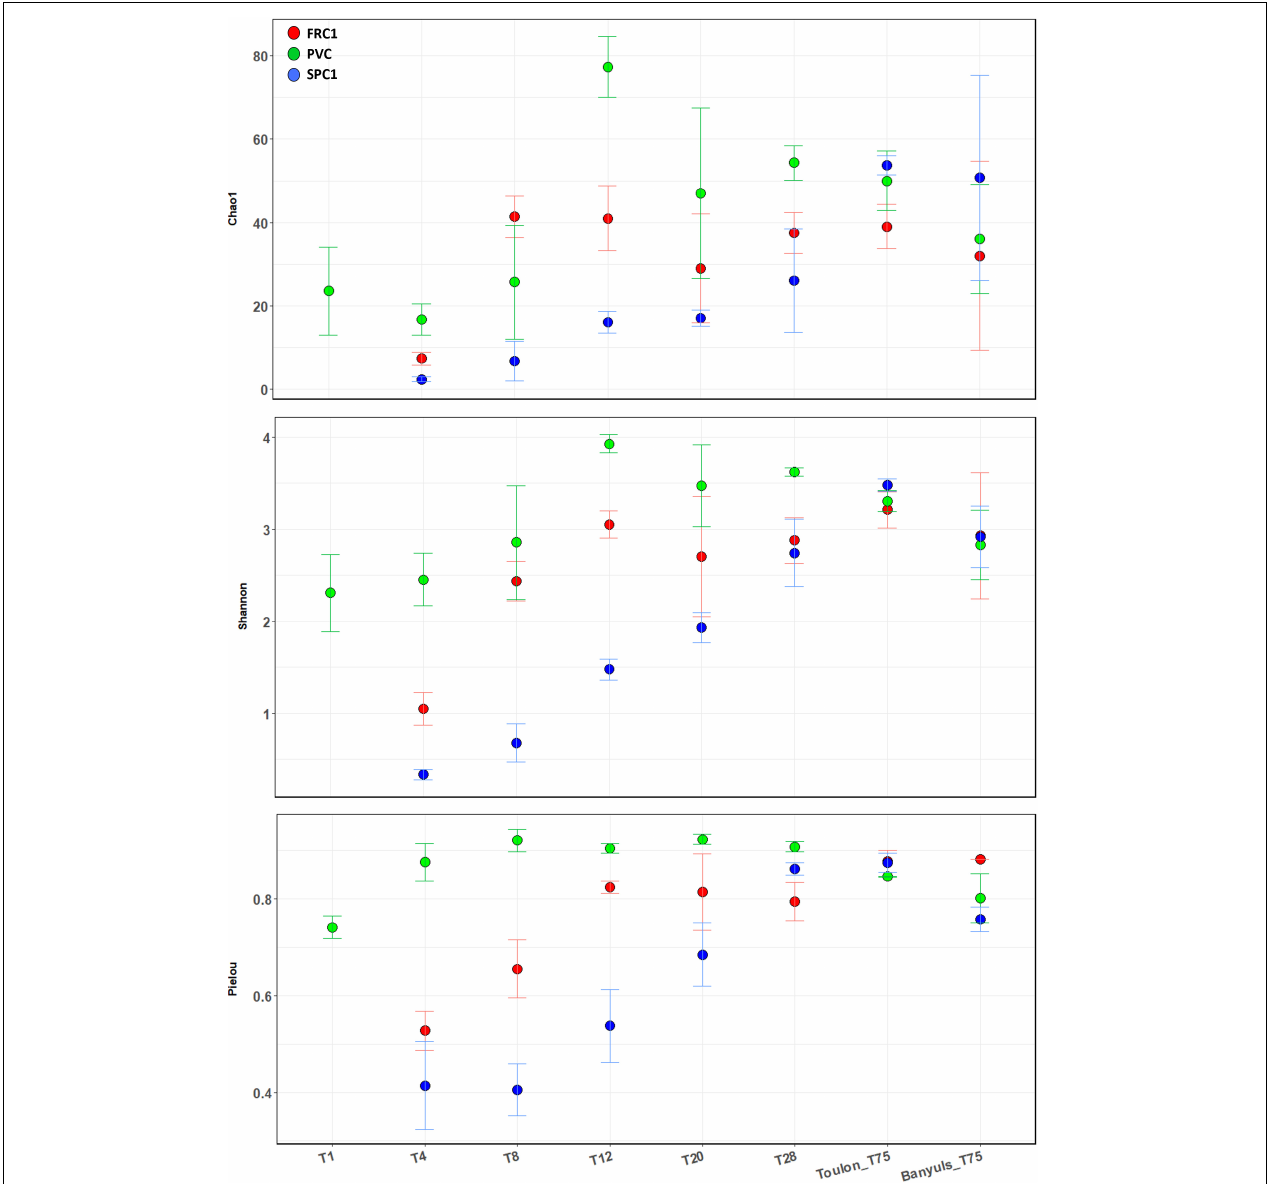
FIGURE 2 | Alpha-diversity indexes (Chao1, Shannon, and Pielou) corresponding to the prokaryotic communities on the different substrates (PVC and two AF coatings, SPC1 and FRC1), time and site (T1-T75 at Toulon bay and T75 only at Banyuls bay). Error bars stand for standard deviations. ANOVA and post hoc Tuckey tests were shown in Supplementary Table 3